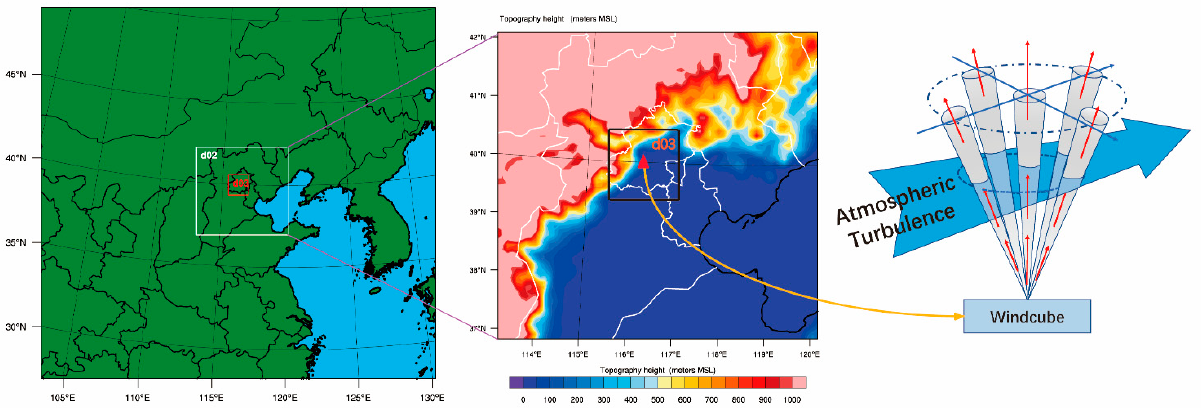
Figure 2. The model topography ( left , middle ) and the schematic diagram of the DWL ( right ) deployed in the center of model domain (red point in the left). Table 1. Comparison of 11 planetary boundary layer schemes.